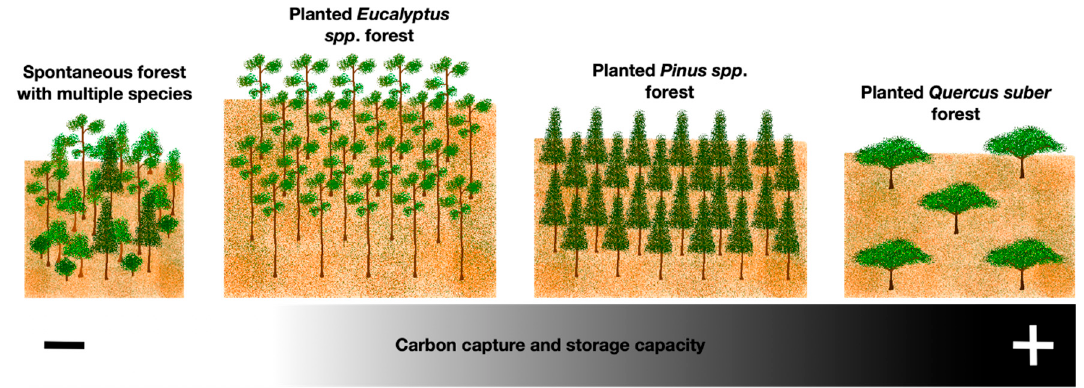
Figure 9. Carbon capture and storage capacity of different forest types.